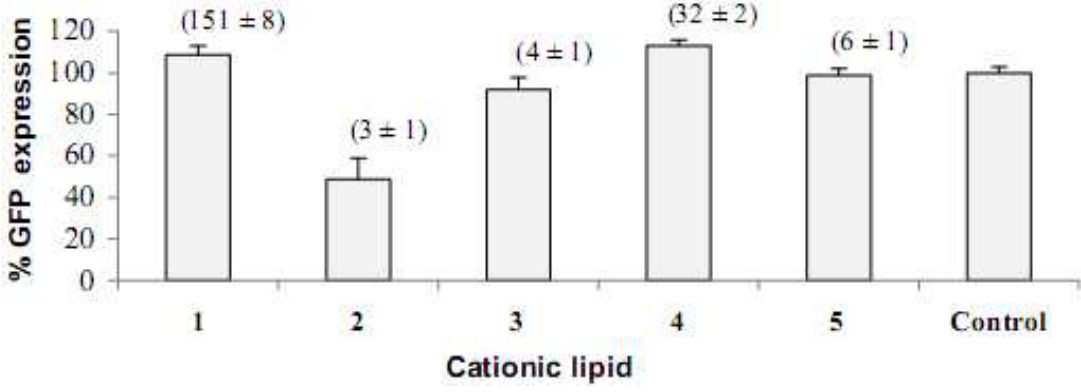
Figure 6. GFP percentage expression 48 h post transfection with scrambled negative control siRNA. Numbers in brackets are siRNA delivery expressed as Alexa Fluor ® 647 normalized geometric mean fluorescence ±